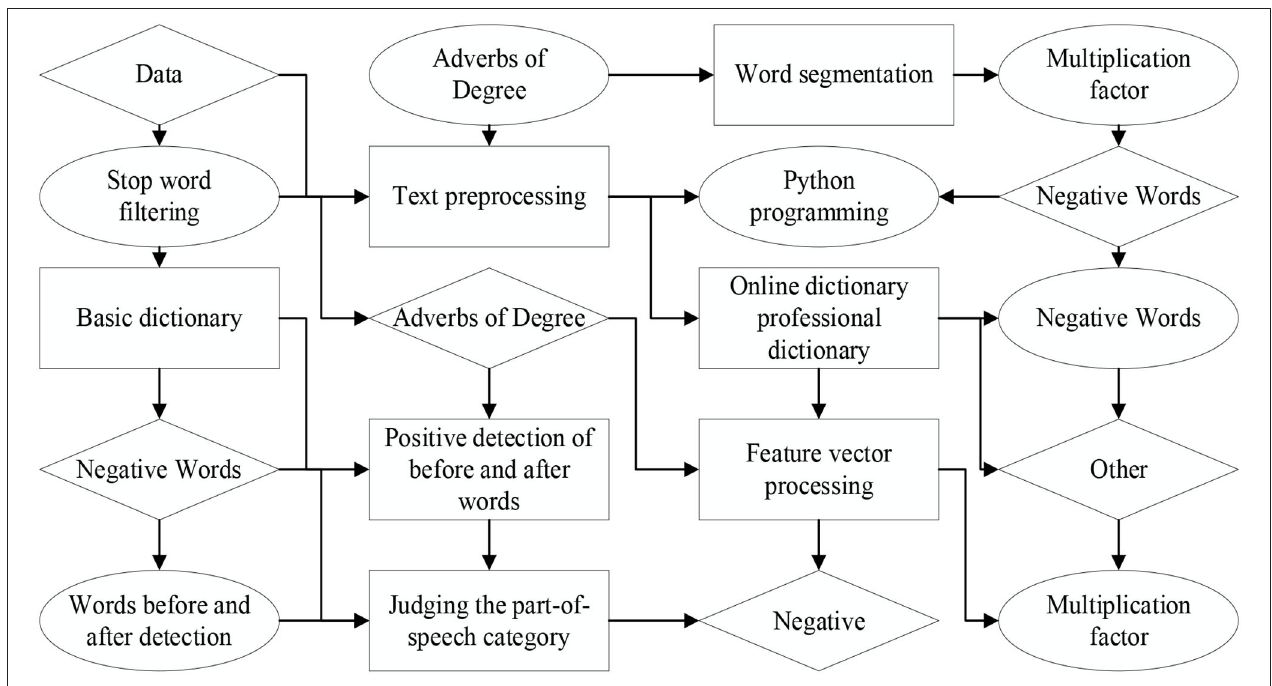
FIGURE 3 | Text analysis principal flow